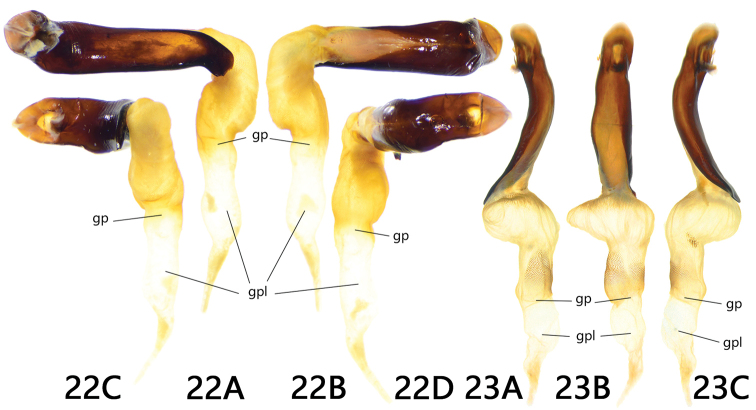
Endophallus22Trigonotoma
dohrniA ventral view B dorsal view C apical view D basal view 23T.
lewisiiA left lateral view B dorsal view C right lateral view.